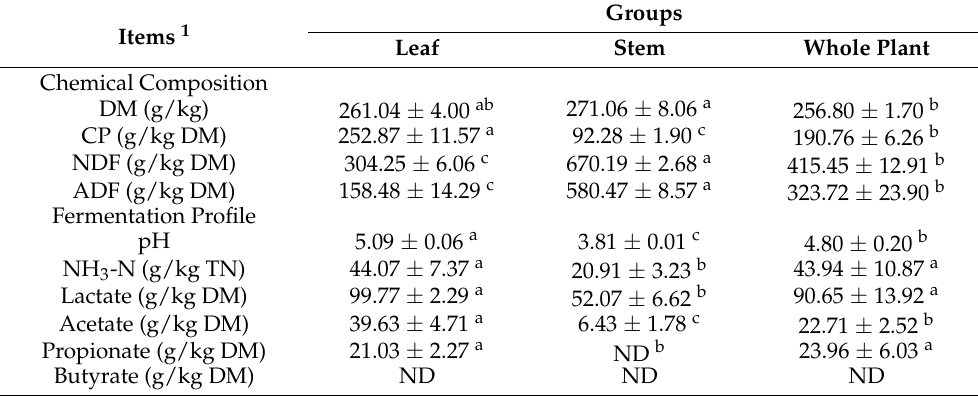
Table 3. Chemical composition and fermentation profile of different parts of paper mulberry silage. Groups Items 1 Leaf Stem Whole Plant Chemical Composition DM (g/kg) 261.04 ± 4.00 ab 271.06 ± 8.06 a 256.80 ± 1.70 b CP (g/kg DM) 252.87 ± 11.57 a 92.28 ± 1.90 c